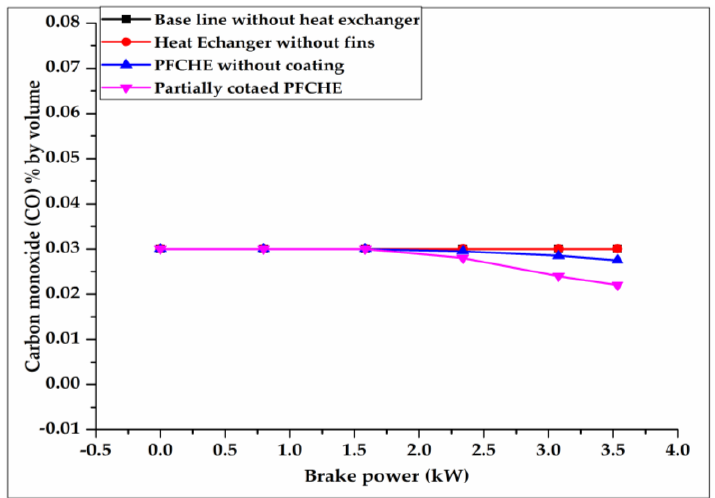
Figure 10. Effect of heat exchanger on CO emission.